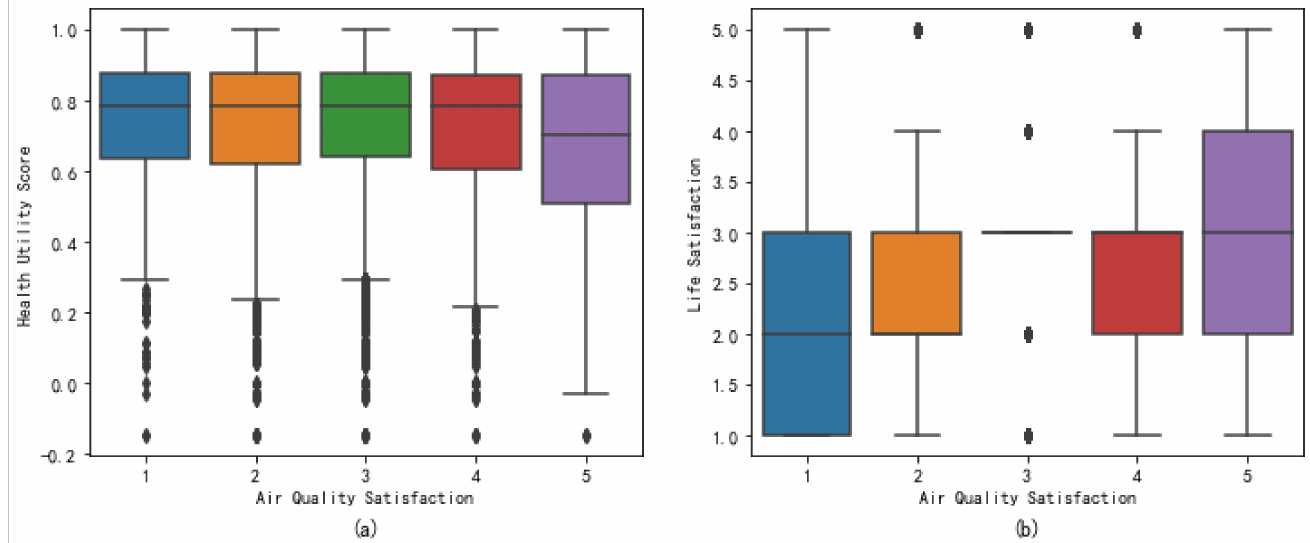
Figure 1. Distribution of air quality satisfaction and QOL utility data. ( a ) The comprehensive distribution characteristics of air quality satisfaction and Health Utility Score (EQ-5D). ( b ) The comprehensive distribution characteristics of air quality satisfaction and Life Satisfaction. (The five colors represent air quality satisfaction, respectively: completely satisfied, very satisfied, somewhat satisfied, not very satisfied, not at all satisfied. Black dots present the outlier